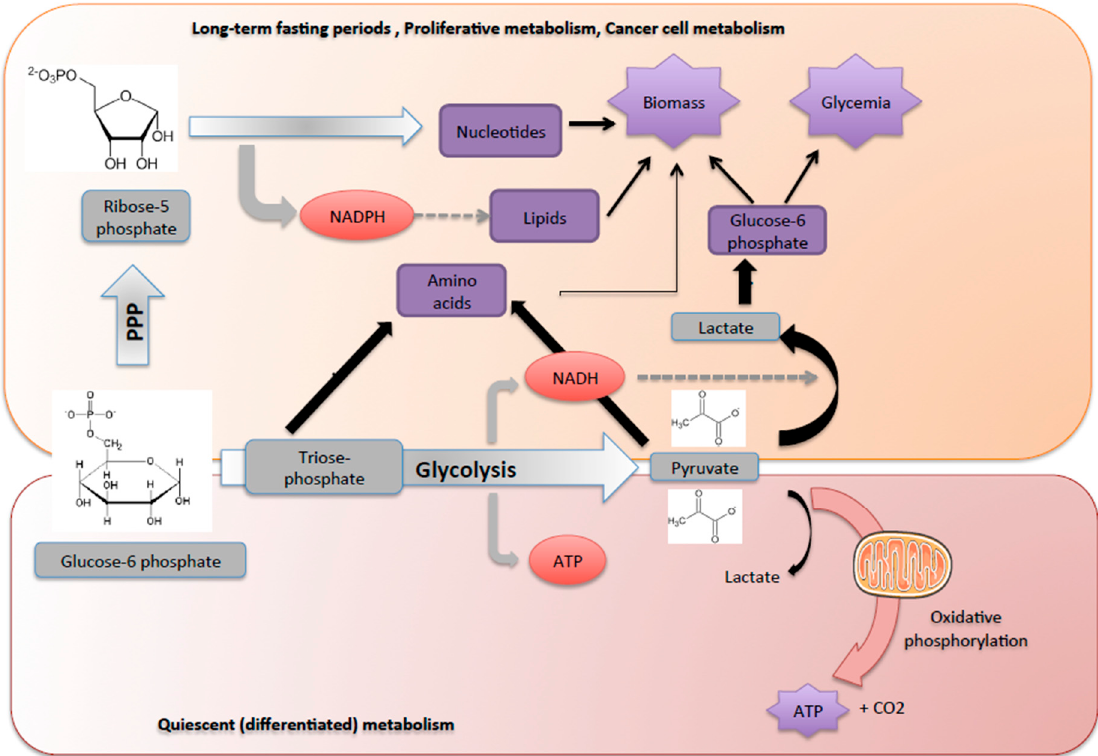
Figure 3. Glucose-6 phosphate: a source of energy and carbon skeletons. The G6P is metabolized either through the glycolytic pathway or PPP, which are tightly connected, depending on metabolic demands. Non-dividing normal differentiated cells mainly depend on mitochondrial oxidative phosphorylation of pyruvate, which is produced from glycolysis, to generate ATP. During cell proliferation or starvation periods, G6P is preferentially metabolized via PPP to maintain carbon homeostasis and produce biomass. In this case, glycolysis produces pyruvate and lactate as final metabolites and becomes inefficient in producing ATP. Indeed, G6P is preferentially metabolized via PPP to provide precursors for nucleotide and amino acid biosynthesis and to provide reducing molecules in the form of NADPH used in reductive biosynthesis reactions within cells (e.g., fatty acid synthesis). Lactate is also used by the hepatocyte to produce glucose and maintain glycaemia.